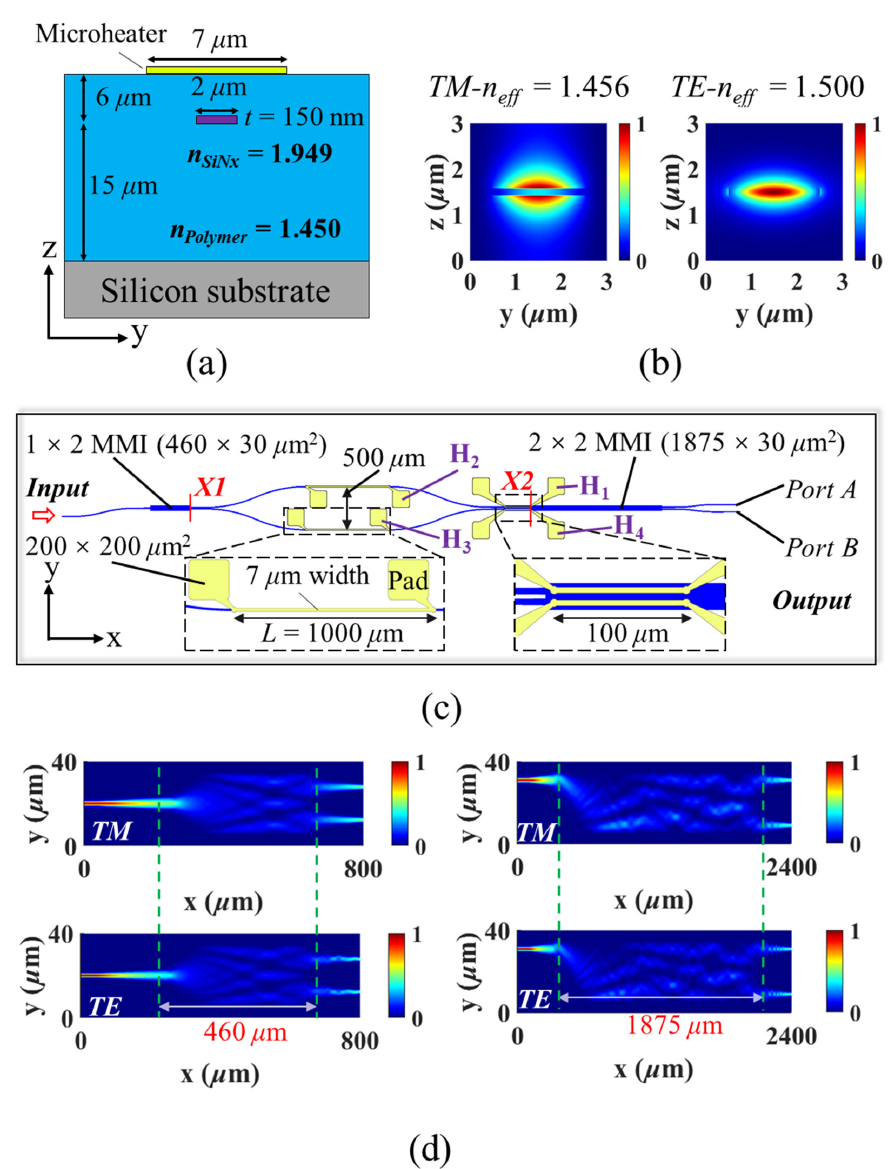
Figure 1. ( a ) The cross section of the thin SiNx waveguide buried in polymer. ( b ) The simulated TE and TM mode fields of the single-mode waveguide, showing distinct waveguide birefringence. ( c ) Schematic of the function-versatile thermo-optic switch with a 1 × 2 MMI splitter, 2 phase-shifting waveguide arms, and a tunable 2 × 2 MMI coupler. ( d ) The simulated results of the polarization insensitive 1 × 2 MMI splitter and the 2 × 2 MMI coupler for the TE and TM polarizations without heater. Critical to the function are the phase values from the end-plane of the 1 × 2 MMI ( X1 ) to the end-plane of the heater-region in the 2 × 2 MMI ( X2 ), in relation to the up and down paths, as well as the TE and TM polarizations. The phases at plane X2 can be expressed as: